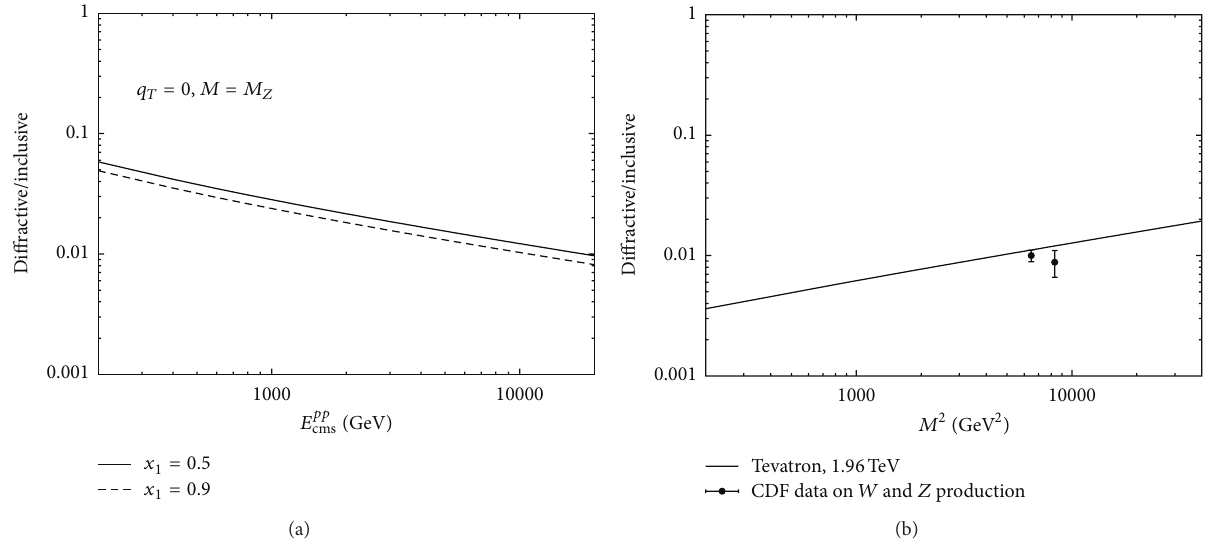
Figure 11: The SD-to-inclusive ratio of the gauge bosons production cross sections as a function of the c.m. energy √𝑠 (a) and the lepton pair invariant mass 𝑀 2 at the Tevatron